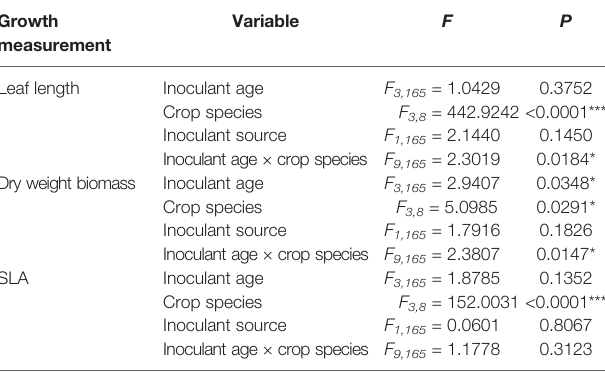
Maize ( Z. mays ), tomato ( S. lycopersicum ), cucumber ( C. sativus ), and lettuce ( L. sativa ) plants were inoculated with soil microbiomes from agricultural (0 years) or fallow plots of different ages (1, 3, or 16 years post-agriculture), with 2 plots representing each age (inoculantsource).Plantgrowthwasmeasuredasthelengthofthelongestleaf,dryweight biomass (roots and shoots), and speci fi c leaf area (SLA). N = 11-12 per species × inoculant age treatment. Note that 2 leaves had been harvested prior to the dry weight measurement for use in the herbivore resistance bioassays. *p < 0.05, ***p <